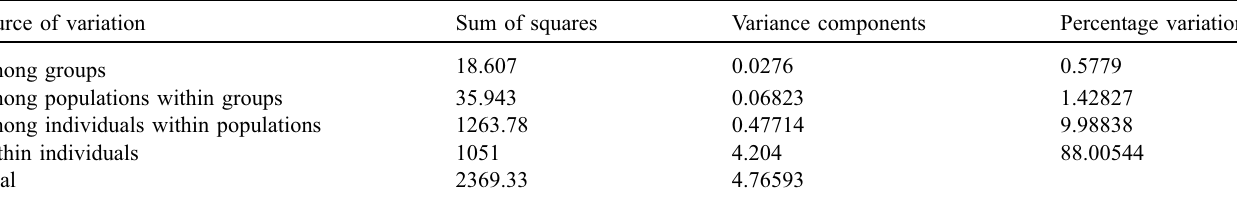
Table 4. Hierarchical Analysis of Amova Variance (AMOVA) based on microsatellite markers in S. commerson populations, F ST : 0.023, P > 0.01